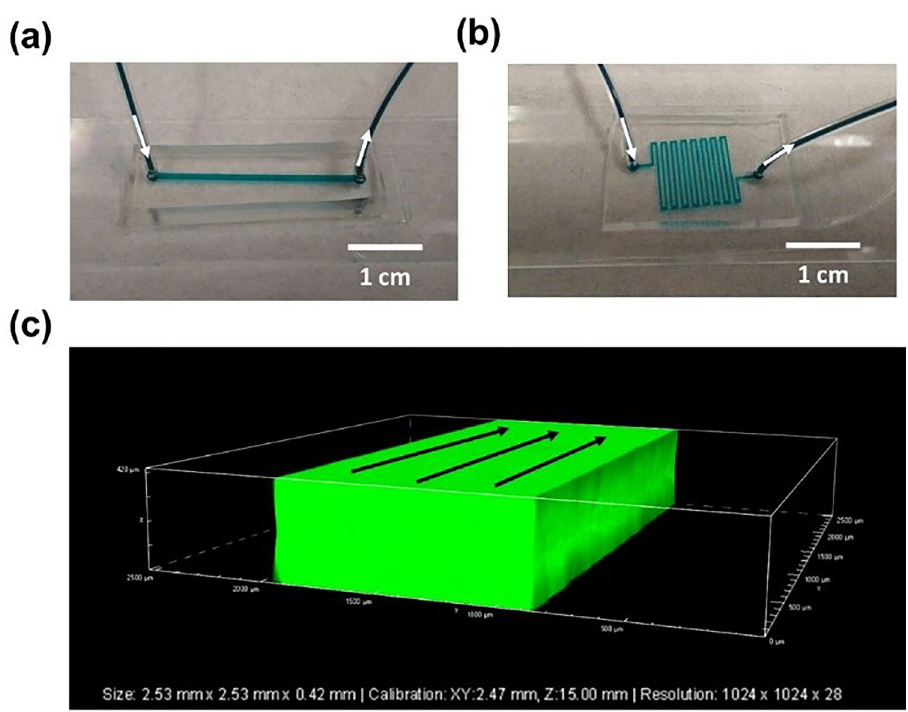
Figure 5. Clogging test of the fabricated microchannels. A dye solution was introduced into the ( a ) straight and ( b ) serpentine microchannels. The dye flowed through the microchannels, confirming both microchannels were totally unclogged. White arrows indicate the flow direction. ( c ) Confocal laser scanning microscopy of the straight microchannel filled with a fluorescent dye. Black arrows indicate the flow